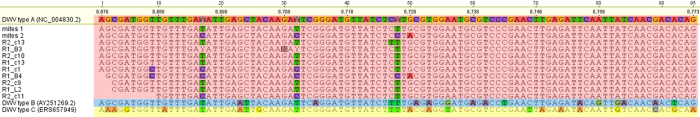
Geneious alignment of a 95 bp fragment amplified from all positive honey bee and mite samples aligned to DWV type A (pink).DWV types B (blue) and C (yellow) are also shown.